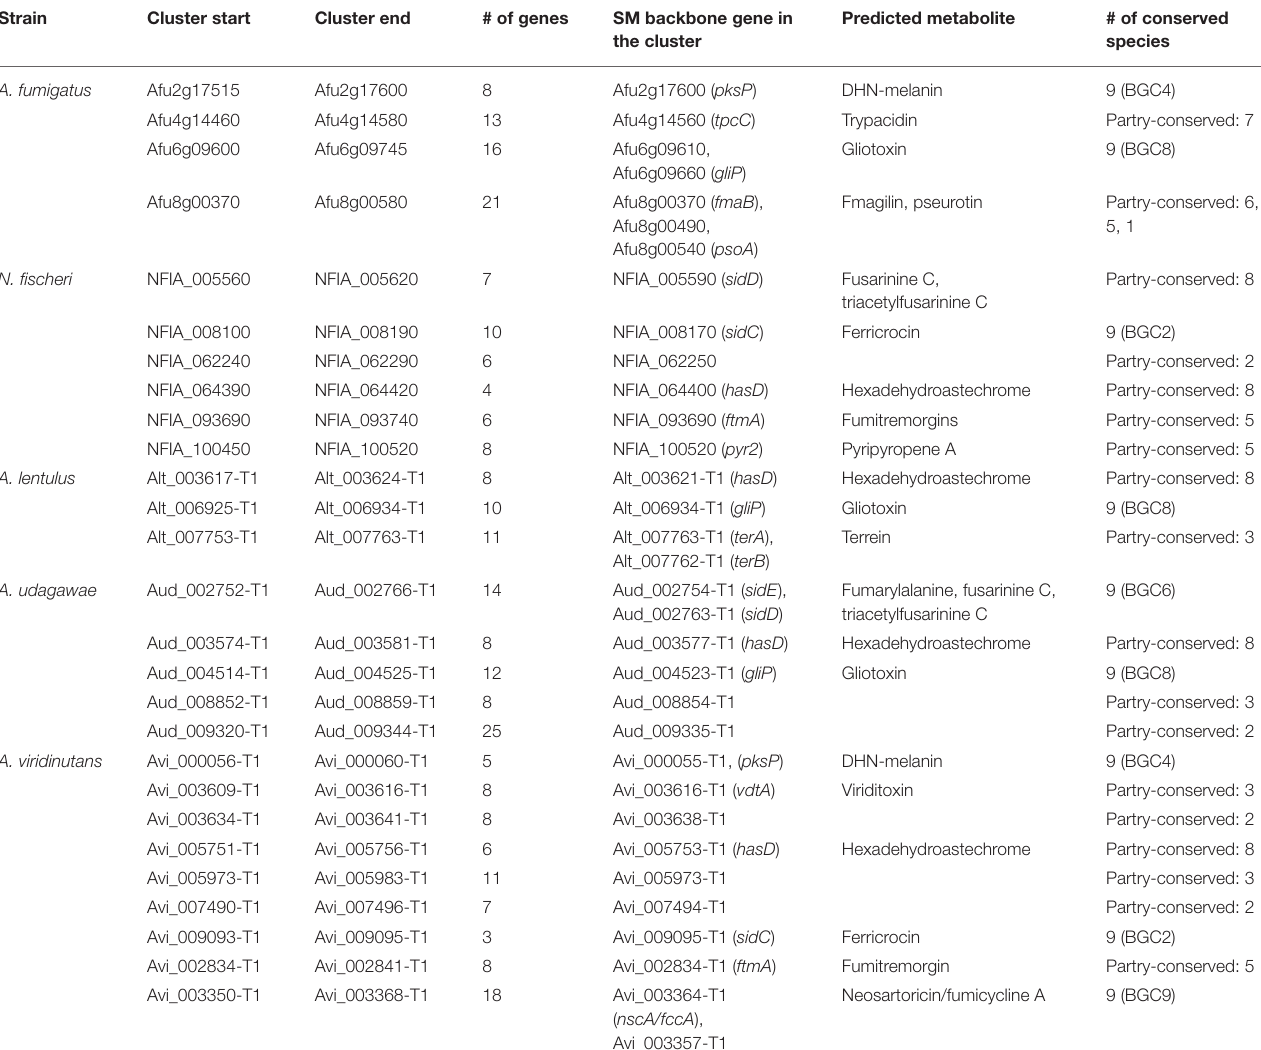
TABLE 3 | Coordinately expressed SM gene clusters identified by MIDDAS analysis.